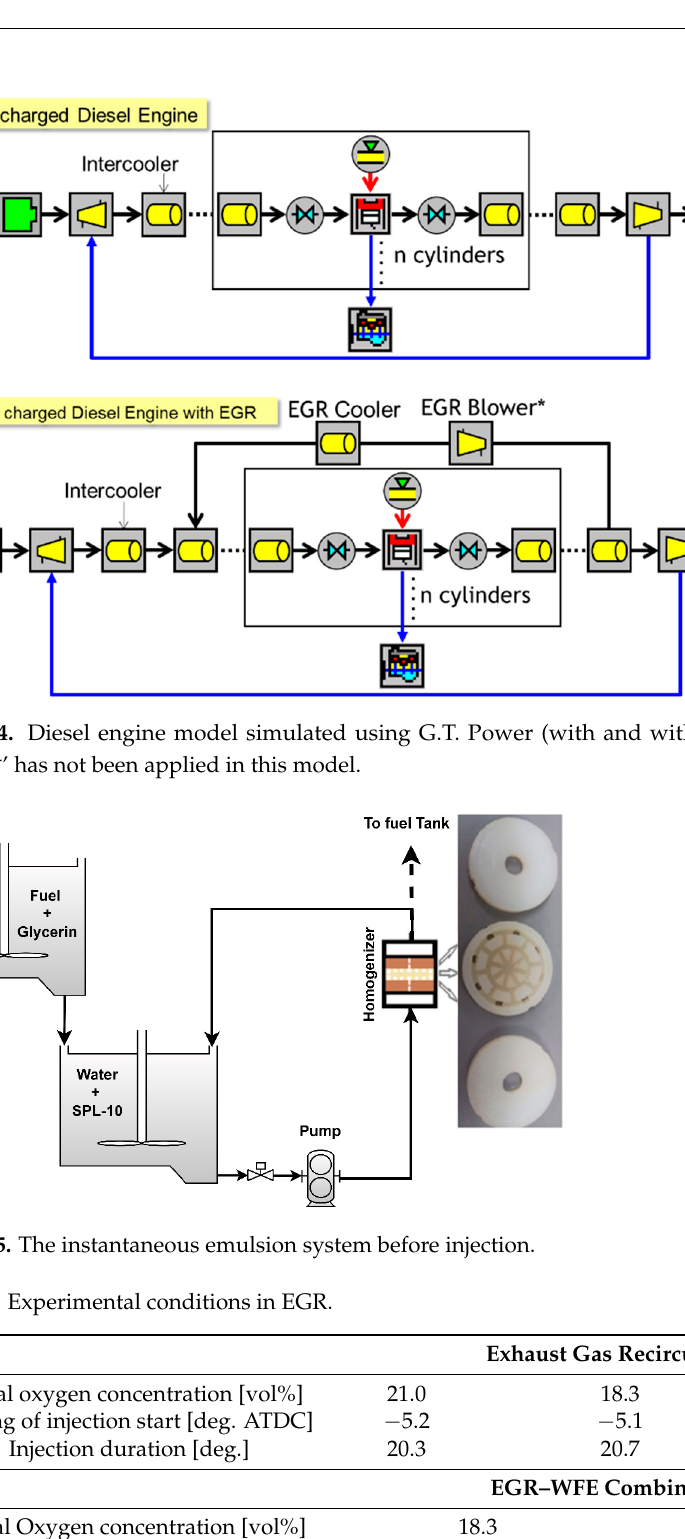
Figure 4. Diesel engine model simulated using G.T. Power (with and without EGR); The ‘EGR Blower*’ has not been applied in this model.